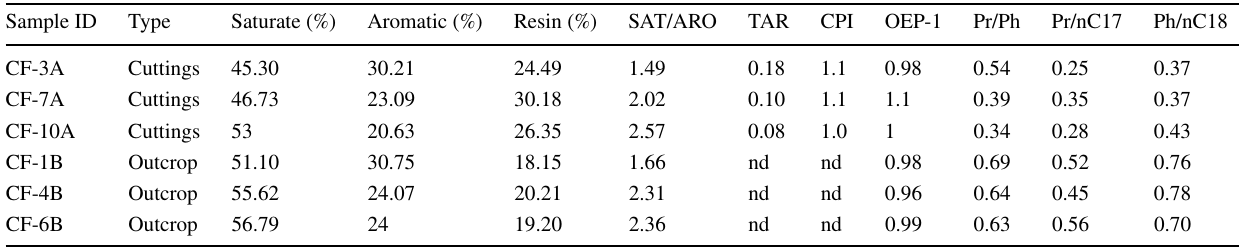
Table 6 The molecular composition as well as geochemical parameters based on n-alkanes and isoprenoid of the Chichali Formation